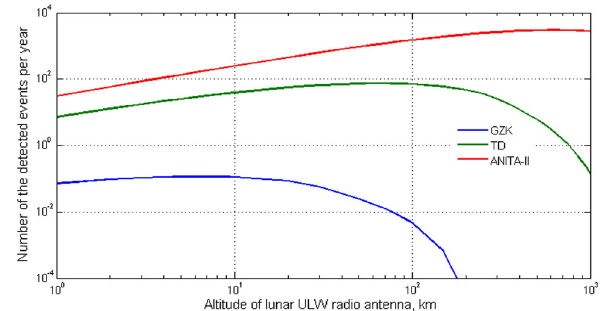
Fig. 8 The UHE neutrino flux of a lunar orbital ULW radio antenna at different altitudes of 50, 100, 300, and 500km for one-year observation. The results are compared with the flux limits of the SKA Low for a 1000-h observation between 100 and 350 MHz (reproduced from Bray et al. [9]), LOFAR for a 90-day observation between 125 and 175 MHz (reproducedfromSinghetal.[47]).Thebluechain-dottedlinesshowthe predicted fluxes from the GZK [20], and topological defects (TD) [45]. The green dashed lines show the flux limits set by the past experiments of ANITA-II [24], IceCube [3] and Auger [2]